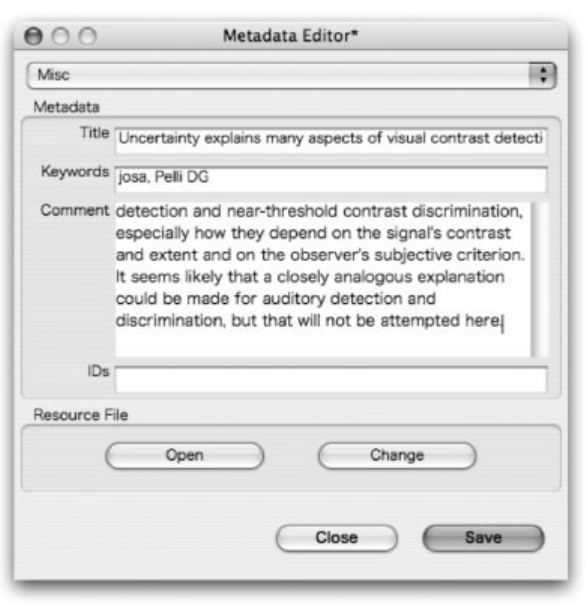
Figure4. AnXMLdocumentformetadataofa“Misc”typeresource .Meta- data entered on an edit dialog are parsed automatically to the XML